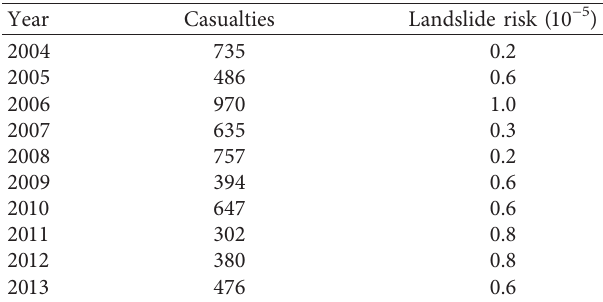
Table 1: Statistics of the casualties of landslide hazard in China each year [28].